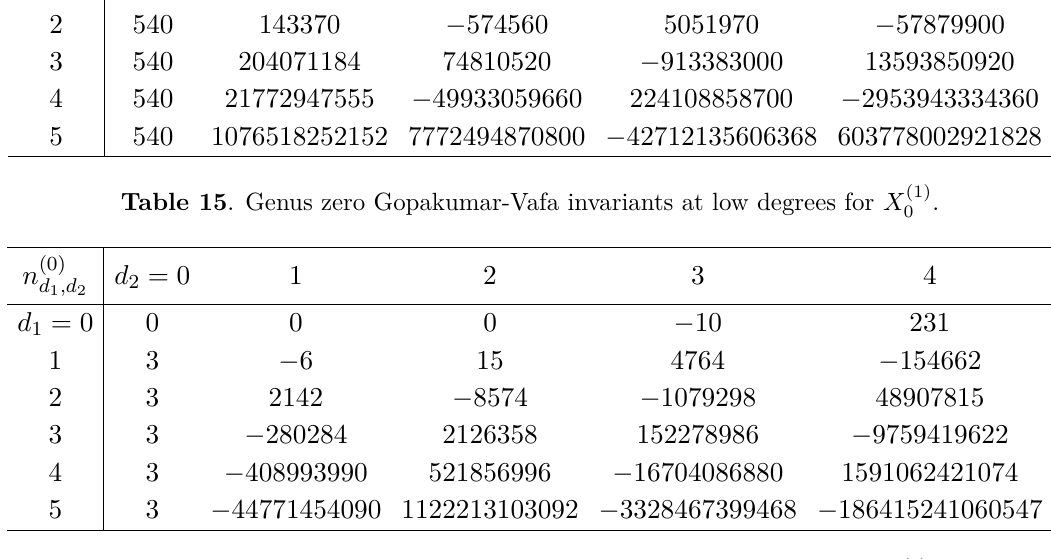
Table 16 . Genus one Gopakumar-Vafa invariants at low degrees for X (1)